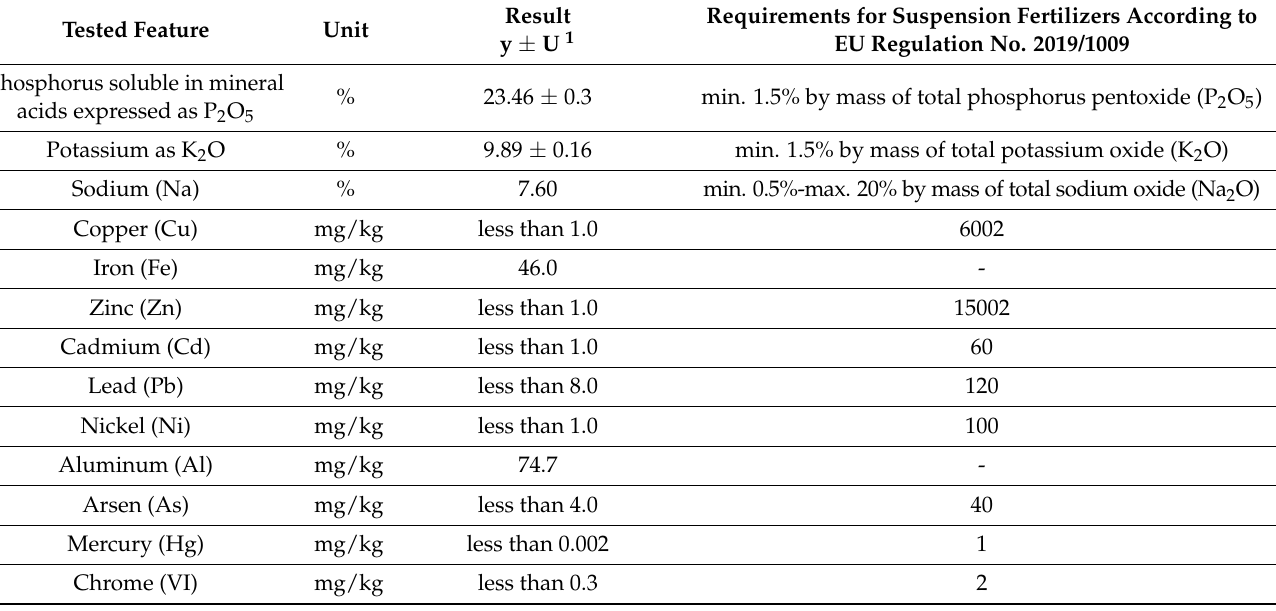
Table 3. The results of the chemical analysis of the waste.